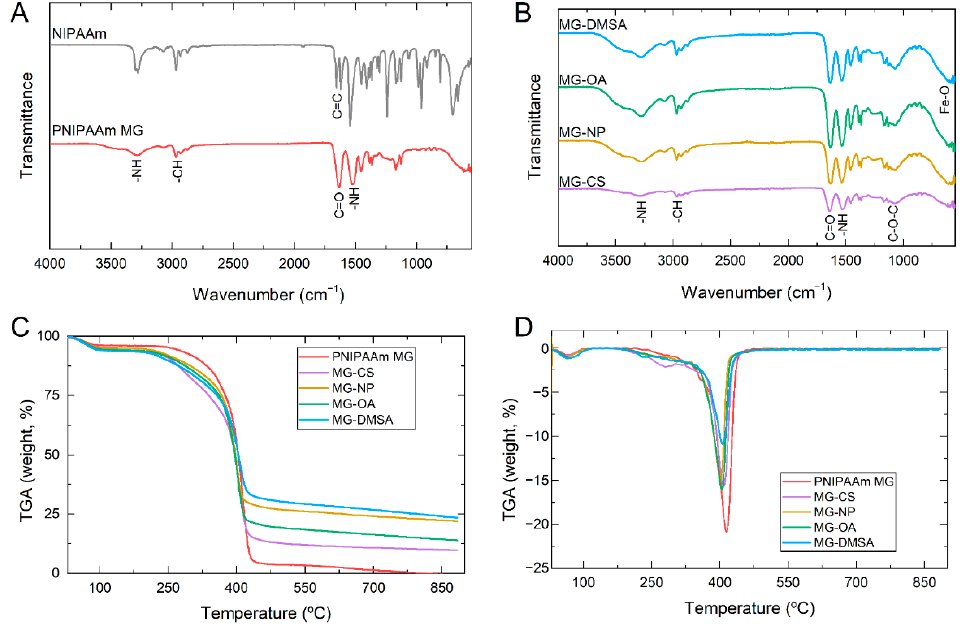
Figure 1. Fourier transform infrared (FTIR) spectra of Poly (N-isopropyl acrylamide) microgels (PNIPAAm MG) compared to its monomer, N -isopropyl acrylamide (NIPAAm) ( A ), and PNIPAAm microgels with chitosan (CS) and Fe 3 O 4 NPs incorporated ( B ). Thermogravimetric analysis ( C ) and the corresponding derivative (DTA) ( D ) of plain PNIPAAm microgels, and PNIPAAm microgels with chitosan and Fe 3 O 4 NPs incorporated. (MG-CS: PNIPAAm microgels with chitosan; MG-NP: PNIPAAm microgels with bare Fe 3 O 4 NPs; MG-OA: PNIPAAm microgels with Fe 3 O 4 NPs coated with oleic acid; MG-DMSA: PNIPAAm microgels with Fe 3 O 4 NPs coated with dimercaptosuccinic acid).